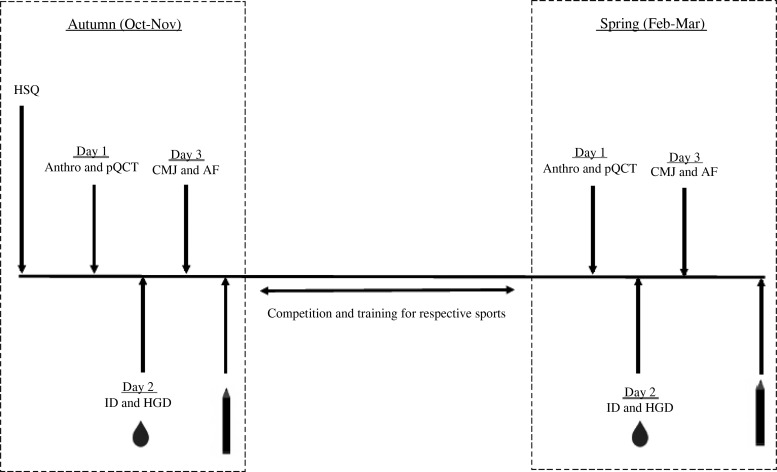
Schematic diagram of study design. HSQ, health screening questionnaire; Anthro, anthropometrics; pQCT, peripheral quantitative computed tomography of non-dominant radius; CMJ, counter movement jump; AF, aerobic fitness; ID, isokinetic dynamomotry; HGD, handgrip dynamomotry; , serum and plasma samples collected (16 ml) and finger prick test; , 5-d self-reported food diary collected.